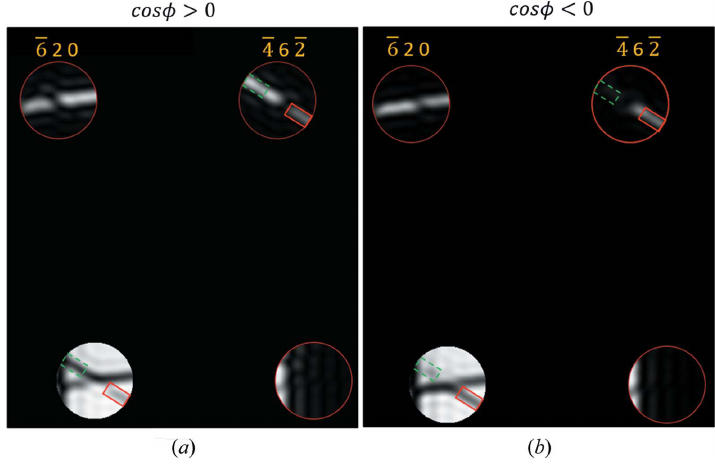
Figure 5 Illustrations of Criterion 5 for determining the sign of cos (cid:2) for thin specimens. The examples are simulated CBED patterns from ( a ) real and ( b ) artificial structures of ZnS in a [137] zone axis orientation. An approximate three-beam condition is located in the centre of each disc. Following the convention in Fig. 1, the regions with negative and positive (cid:5) h are labelled with equally sized rectangles with dashed (green) and solid (red) lines, respectively. In order to facilitate an inspection, the rectangles are located away from the exact three-beam condition by the same distance. In the simulations, the following values for the three-phase invariant and the thickness were used: ( a ) (cid:2) = 2.5 (cid:3) , z = 700 A˚ ; ( b ) (cid:2) = (cid:4) 140 (cid:3) , z = 700 A˚ . In the calculation of ( a ), the three-phase invariant was adopted from the structure itself whereas in the calculations of ( b ), the three-phase invariant was artificially adjusted in order to produce a situation such that cos (cid:2) < 0. In this adjustment, the phase of